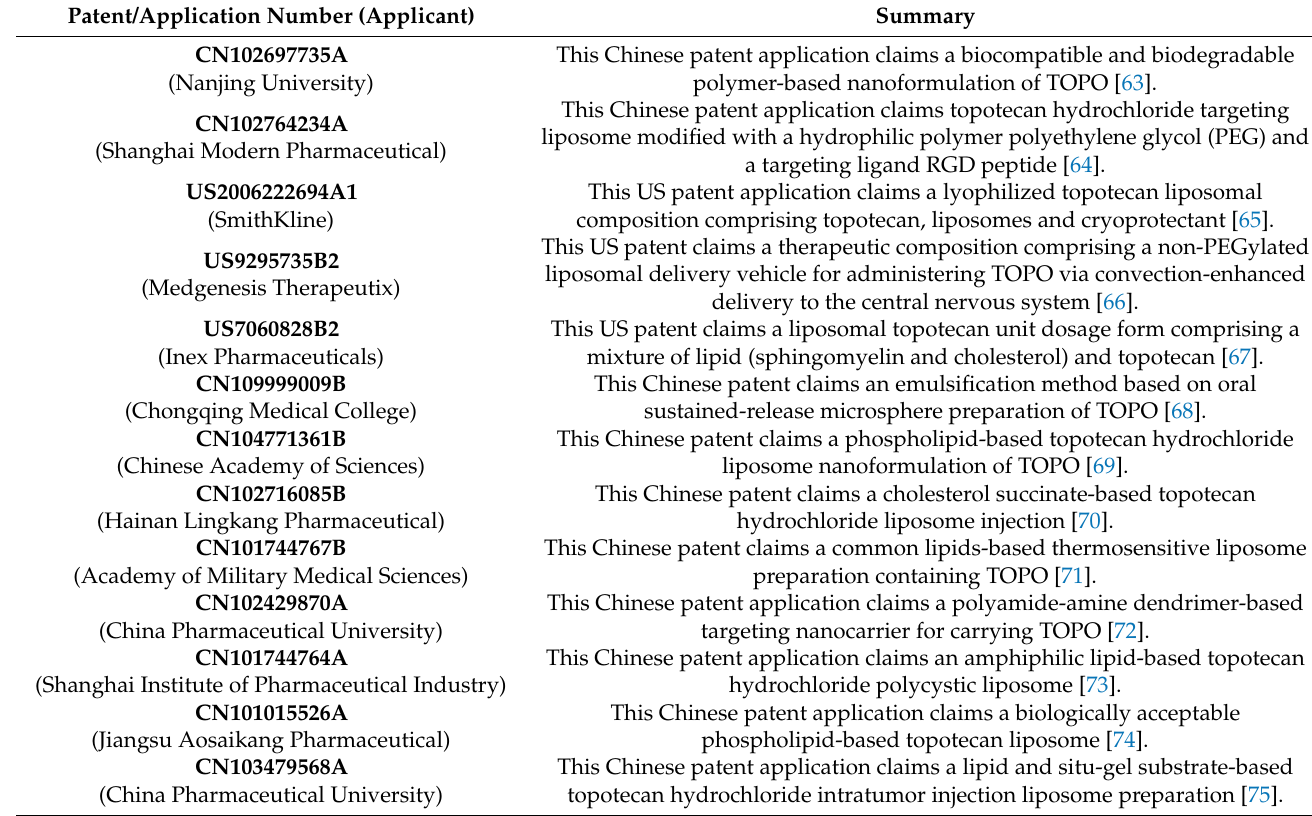
Table 3. Important granted patents/patent applications of